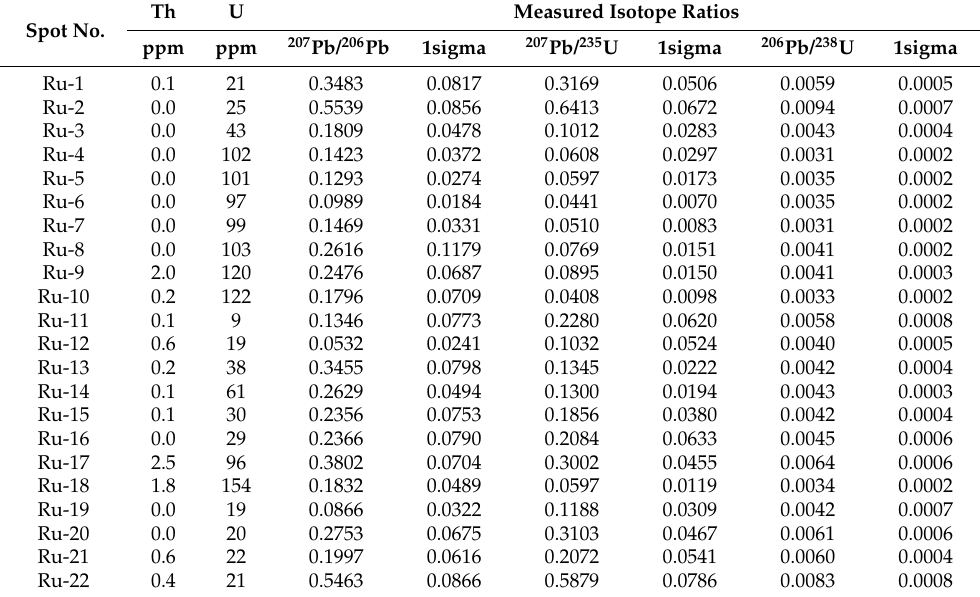
Table 2. LA-ICP-MS U–Pb results of rutile inclusion in ruby, Yuanjiang ruby deposit area. Spot